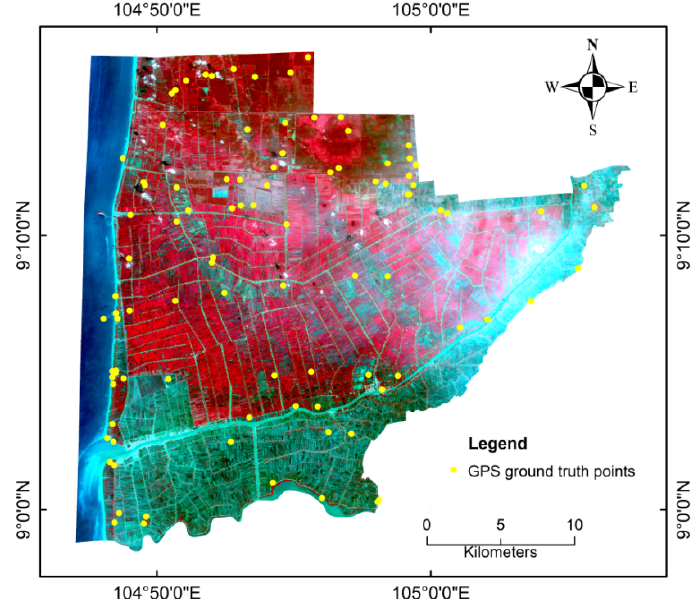
Figure 3. Location of ground control points visited in the field. Background image is the SPOT5 image acquired 3 January 2011.